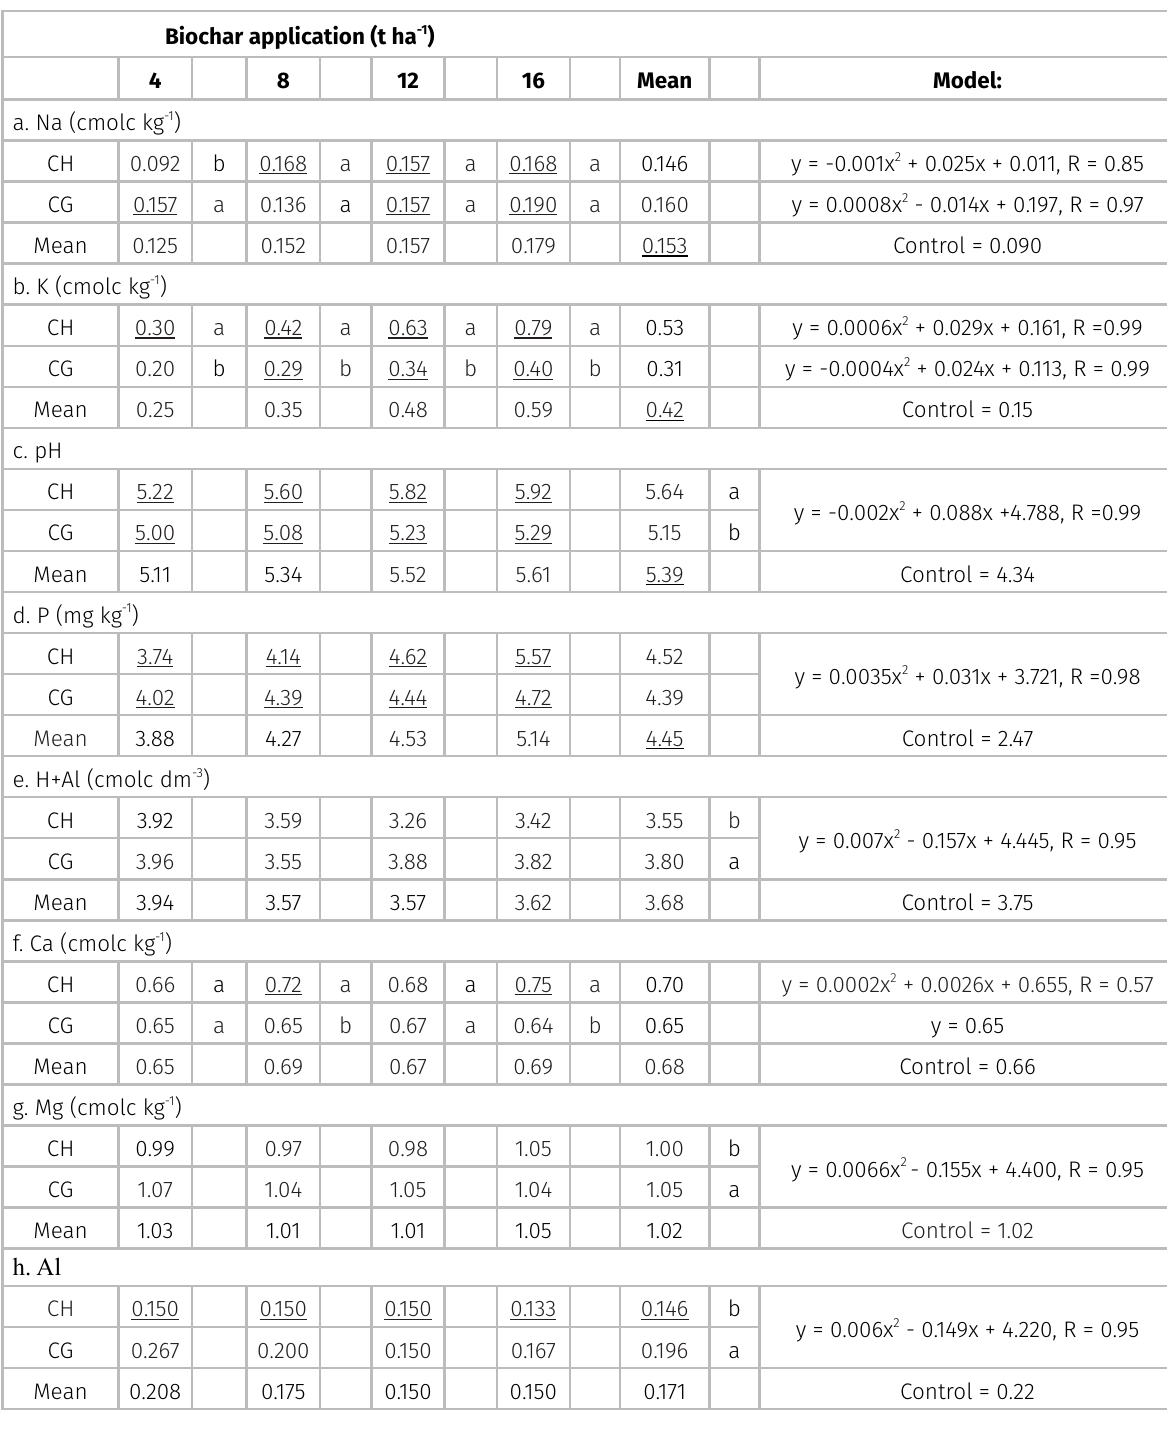
Table III. Chemical attributes, microbial biomass carbon (MBC) and total organic carbon (TOC) of sandy Entisol treated with biochar produced from the coffee ground (CG) and coffee husk (CH) residues, cultivated with the bean plant in Northeastern